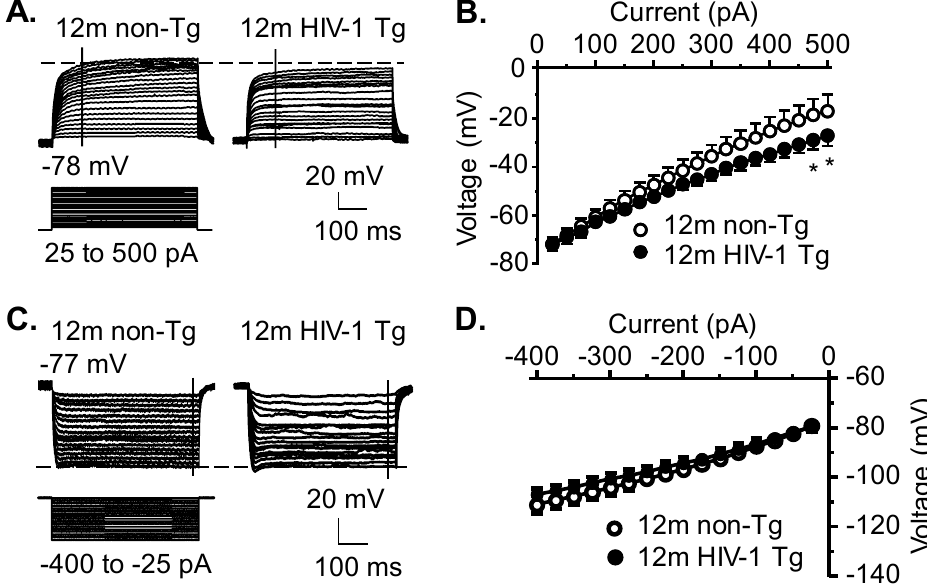
Figure 4. K v channel activity is significantly increased, while activity of functional K ir and K 2P channels is not significantly altered, in striatal MSNs in the context of neuroHIV. ( A ) The responses of membrane potential ( V m ) of striatal MSNs to excitatory stimuli (depolarization), reflecting the activation of K v channels and outflowing voltage-sensitive K + . The vertical dash-lines indicate the time point (100 ms) at which V m changes were assessed. ( B ) The current-voltage ( I–V ) relationships indicate a significant change in V m mediated by K v channels (12mo non-Tg: n = 11 neurons in 9 rats vs. 12mo HIV-1 Tg: n = 9 neurons in 7 rats). Significance is denoted as * p ≤ 0.05. ( C ) The V m changes of striatal MSNs to inhibitory stimuli (hyperpolarization), reflecting the activation of K ir channels and inwardly rectifying K + . The vertical dash-lines indicate the time point (450 ms) at which V m changes were assessed. ( D ) The current-voltage ( I–V ) relationships show no significant change in V m mediated by K ir channels (12mo non-Tg: n = 10 neurons in 8 rats vs. 12mo HIV-1 Tg: n = 8 neurons in 6 rats). Table 2. Summary of the changes in membrane ion channels and ionotropic receptors assessed in GA- BAergic medium spiny neurons from 12mo HIV-1 rats in comparison with age-matched non-Tg rats. Ion Channels/Ionotropic Receptors Location